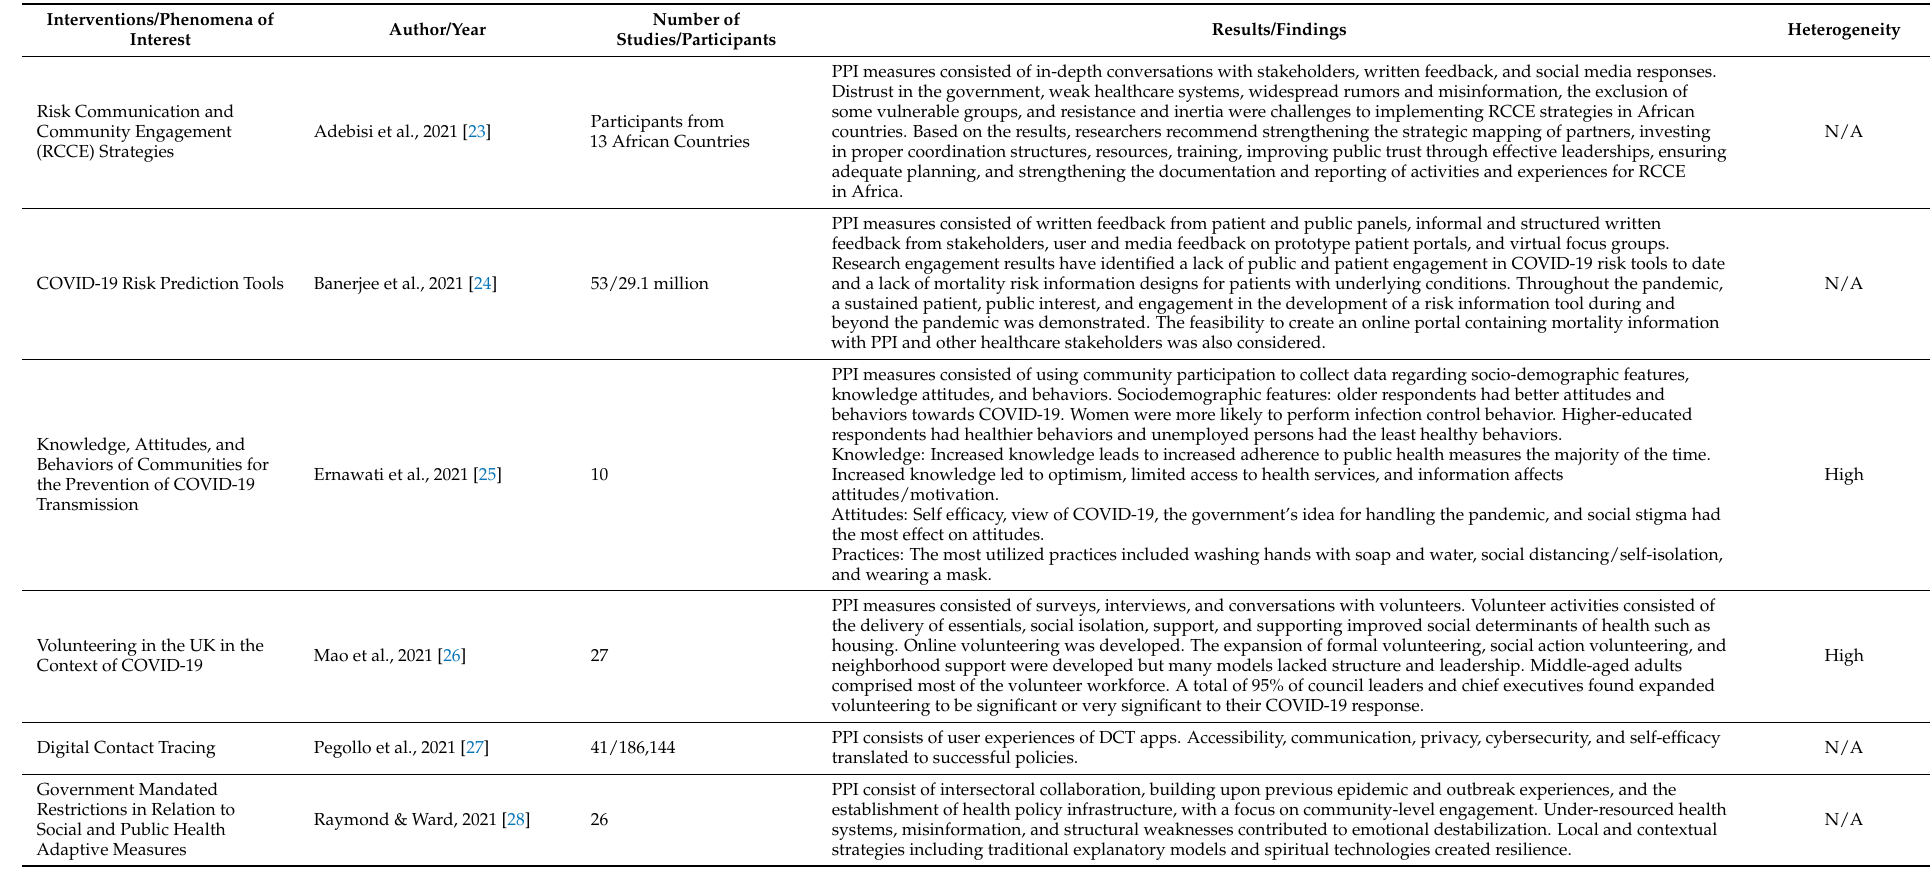
Table 1. Quantitative data from included review